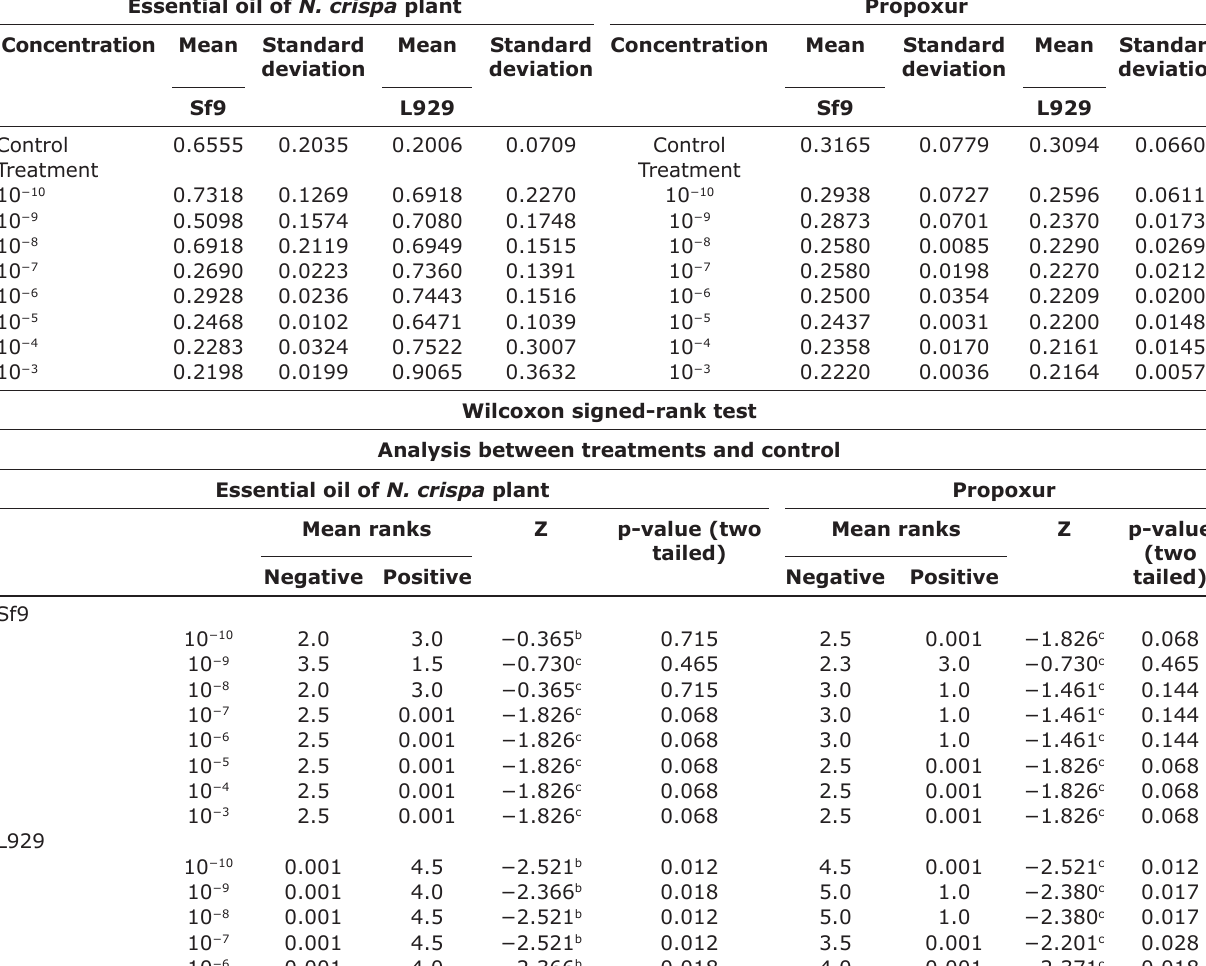
Table-3: Results of Wilcoxon signed-rank test between cytotoxicity of N. crispa essential oil and propoxur against invertebrate (Sf9) and vertebrate (L929) cell lines. Descriptive